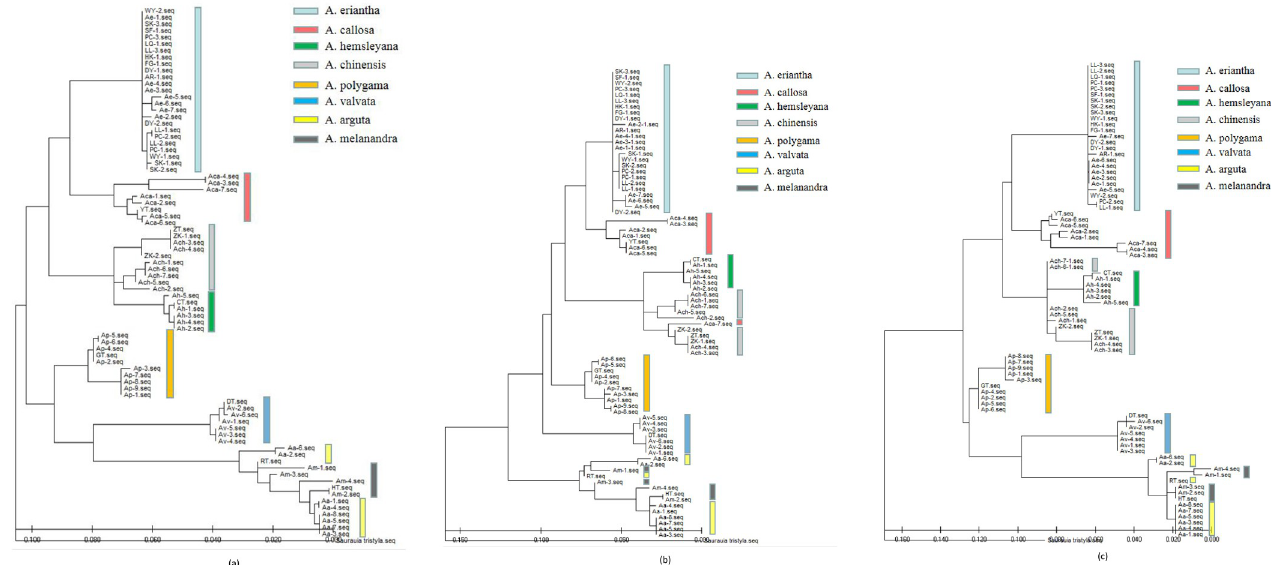
Fig 2. Phylogenetic tree of 8 species of Actinidia . (a) Analysis of ITS sequences fragments; (b) Analysis of ITS1 sequences fragments; (c) Analysis of ITS2 sequences fragments.